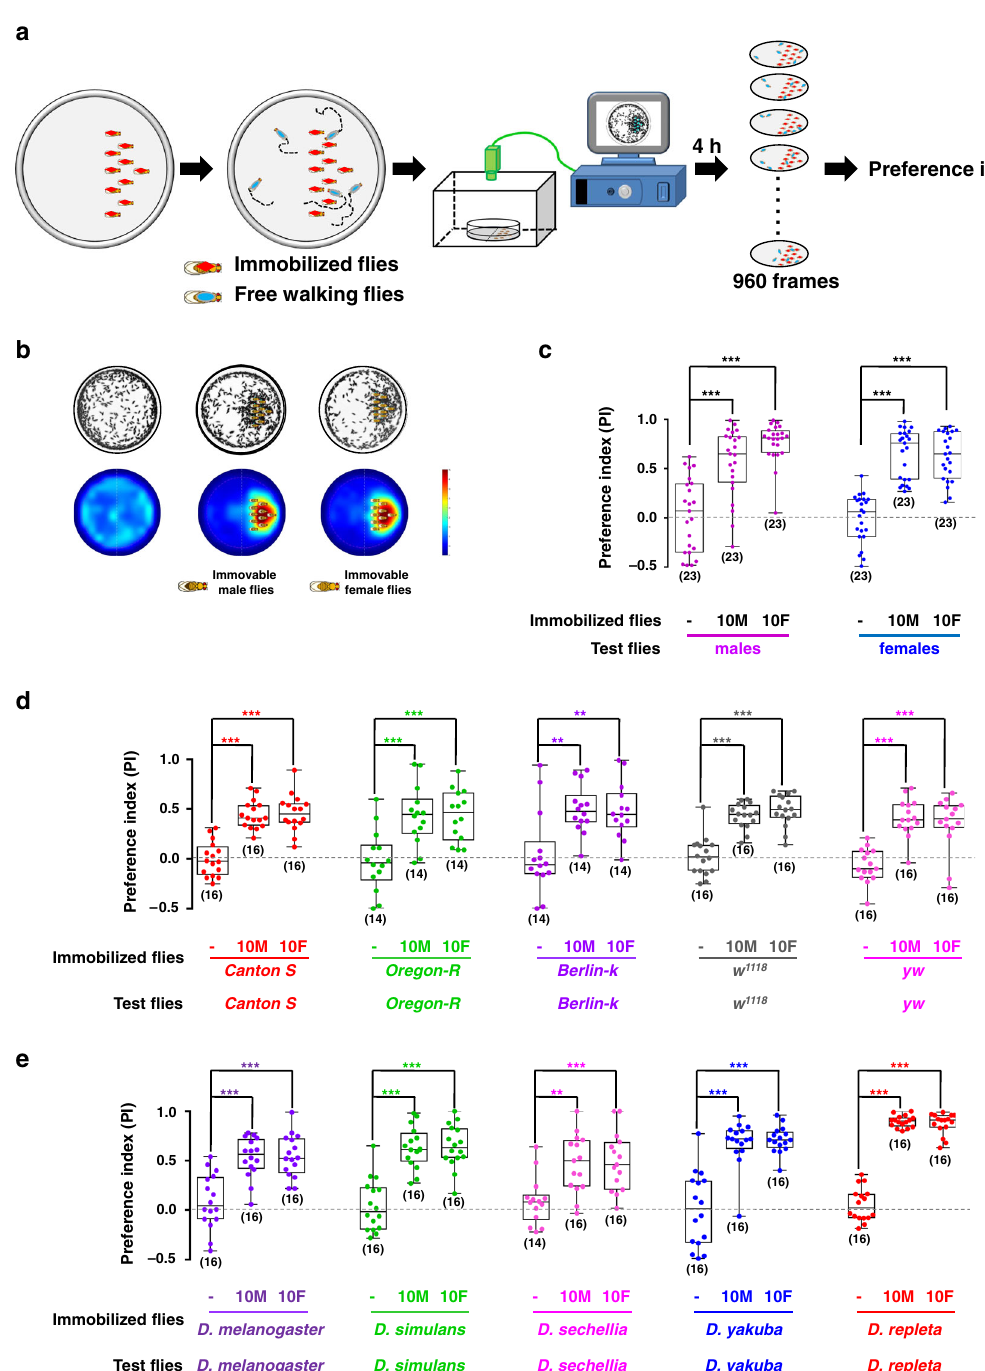
Fig. 1 Social attraction in Drosophila melanogaster . a Procedure for quantifying social approach behaviour. Immobilized attractor fl ies were tethered to the right side of a shallow dish while the left side was empty. The distribution of free-walking fl ies in the dish was tracked using a video camera, and the preference index was calculated (see also Video 1). b Free-walking fl ies were strongly attracted to immobilized fl ies. Top panels: the overlays of 960 frames from a 4-h test period. Bottom panels: accumulated distributions of free-walking fl ies. c Canton S fl ies of both sexes were similarly attracted by male and female attractor fl ies. d Genetic background had minor effects on social attraction. The strains are Canton-S , Oregon-R , Berlin-K , w 1118 , and yw . e Wild fl ies of different species of Drosophilidae exhibit social attraction. The species tested were D. melanogaster , D. simulans , D. sechellia , D. yakuba , and D. repleta . The results are presented as a box and whisker plot; the whiskers indicate the minimum and maximum, the box includes the 25th – 75th percentile, and the line in the box indicates the median of the data set. Statistical analysis: one-way ANOVA followed by Dunnett ’ s test was used for comparison of all groups vs. control group, and t-test for comparisons between only two groups ( e ). ** P < 0.01, *** P <